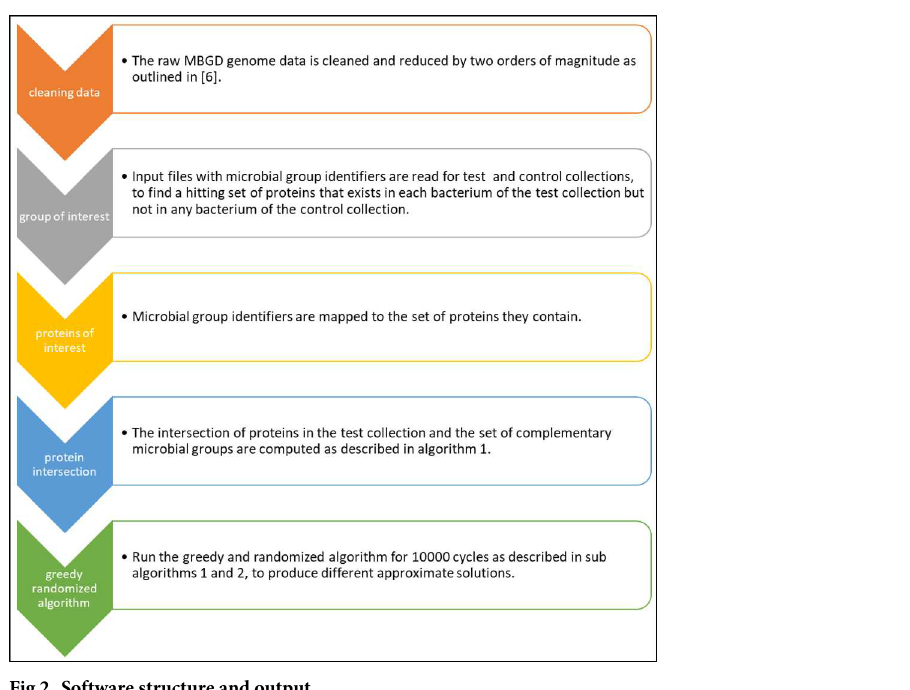
Fig 2. Software structure and